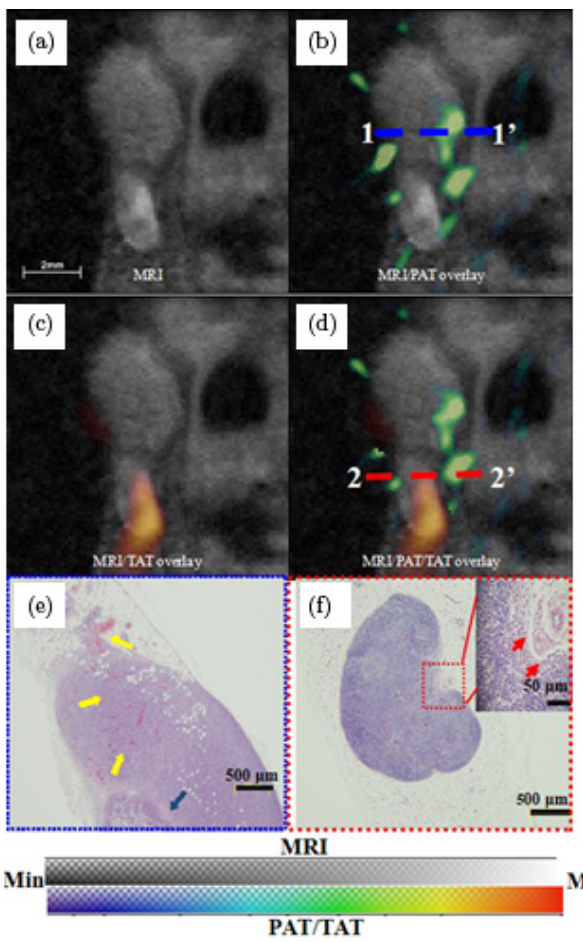
Fig. 3. Combined MR – PA – TA imaging of a lamp-like sus- pected tumor area. Scale bar ¼ 2 mm for (a) – (d). (a) illustrates an MRI image (gray) that clearly shows suspicious lamp-like shapes, signifying the tumor area. However, the suspected area margin is not signi¯cantly di®erent from the surrounding nor- mal tissues without the help of PAT signal overlays (green), shown in (b). (c) displays a fused MRI and TAT image (or- ange), showing a high imaging contrast within the lamp camp. An enhanced TA signal expanding along within the lamp cap can also be observed. This lamp camp is otherwise invisible at lower TA signals. A co-registered MR-PA-TA image given in (d) reveals clearly delineated tumor margins and improved lamp cap contrast, and the overlaid 3D MRI, 2D PAT, and TAT slice images depicting tumor rotation (see Media 1). (e) and (f) show the dashed blue (1 – 1 0 ) and red line (2 – 2 0 ) indi- cated histology analysis cross-sections, respectively. In (e), an intensive vascular network was apparent in one side of the tumor mass (yellow arrow), whereas on the opposite side, tumor necrosis occurred (blue arrow), scale bar ¼ 500 (cid:1) m. The histology analysis of the dashed red line section was shown in (f) (scale bar ¼ 500 (cid:1) m). With the magni¯ed red square area in the inset (scale bar ¼ 50 (cid:1) m), atypical cells emerged in sub capsule (red